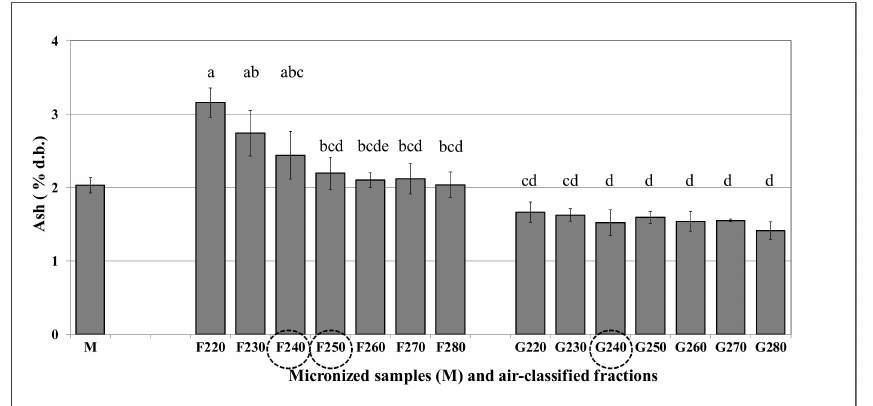
Figure 5. Mean ash percentages (% dry basis) of three durum cultivars: micronized wholemeals (M); air-classified fractions (F and G types). Different letters indicate statistically significant difference ( p < 0.05); circles highlight the fractions with significant differences ( p < 0.05) among cultivars (n = 2).